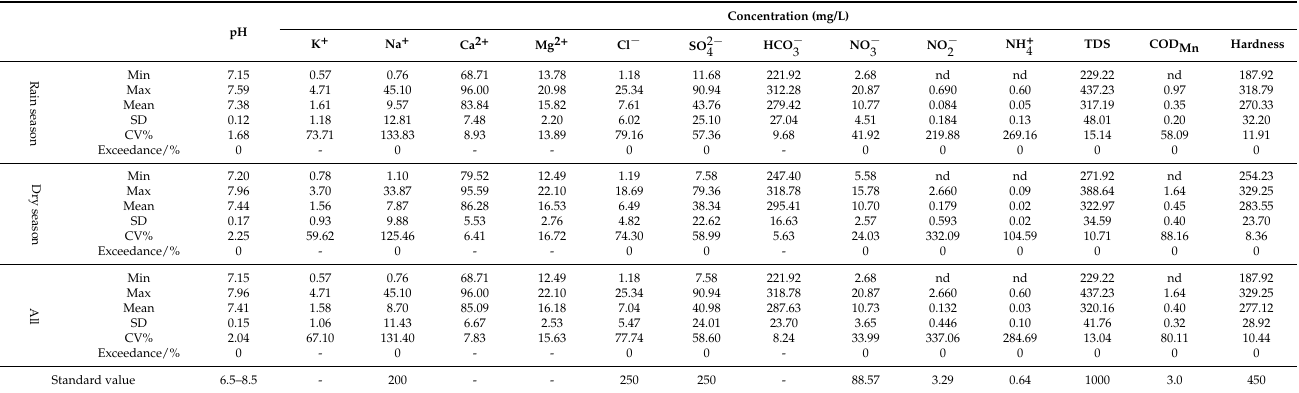
Table 1. Statistics of water chemistry parameters in groundwater (N = 37).